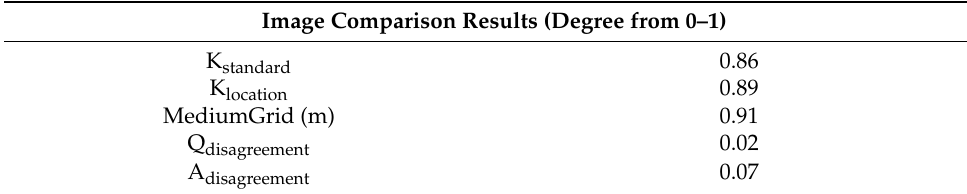
Table 7. Validation results of the simulated map and actual map in 2018.